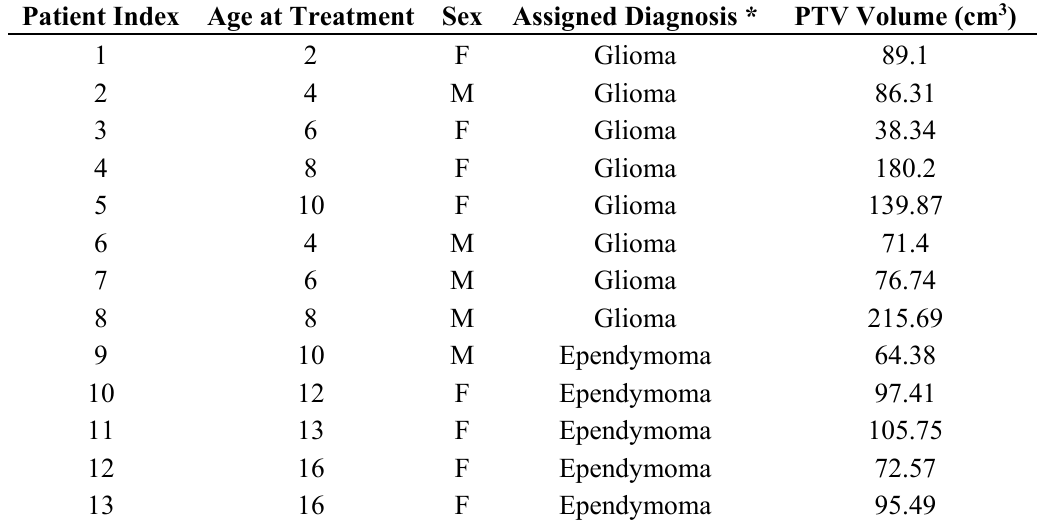
Table 1. Patient index, age, sex, diagnosis used for the study and target